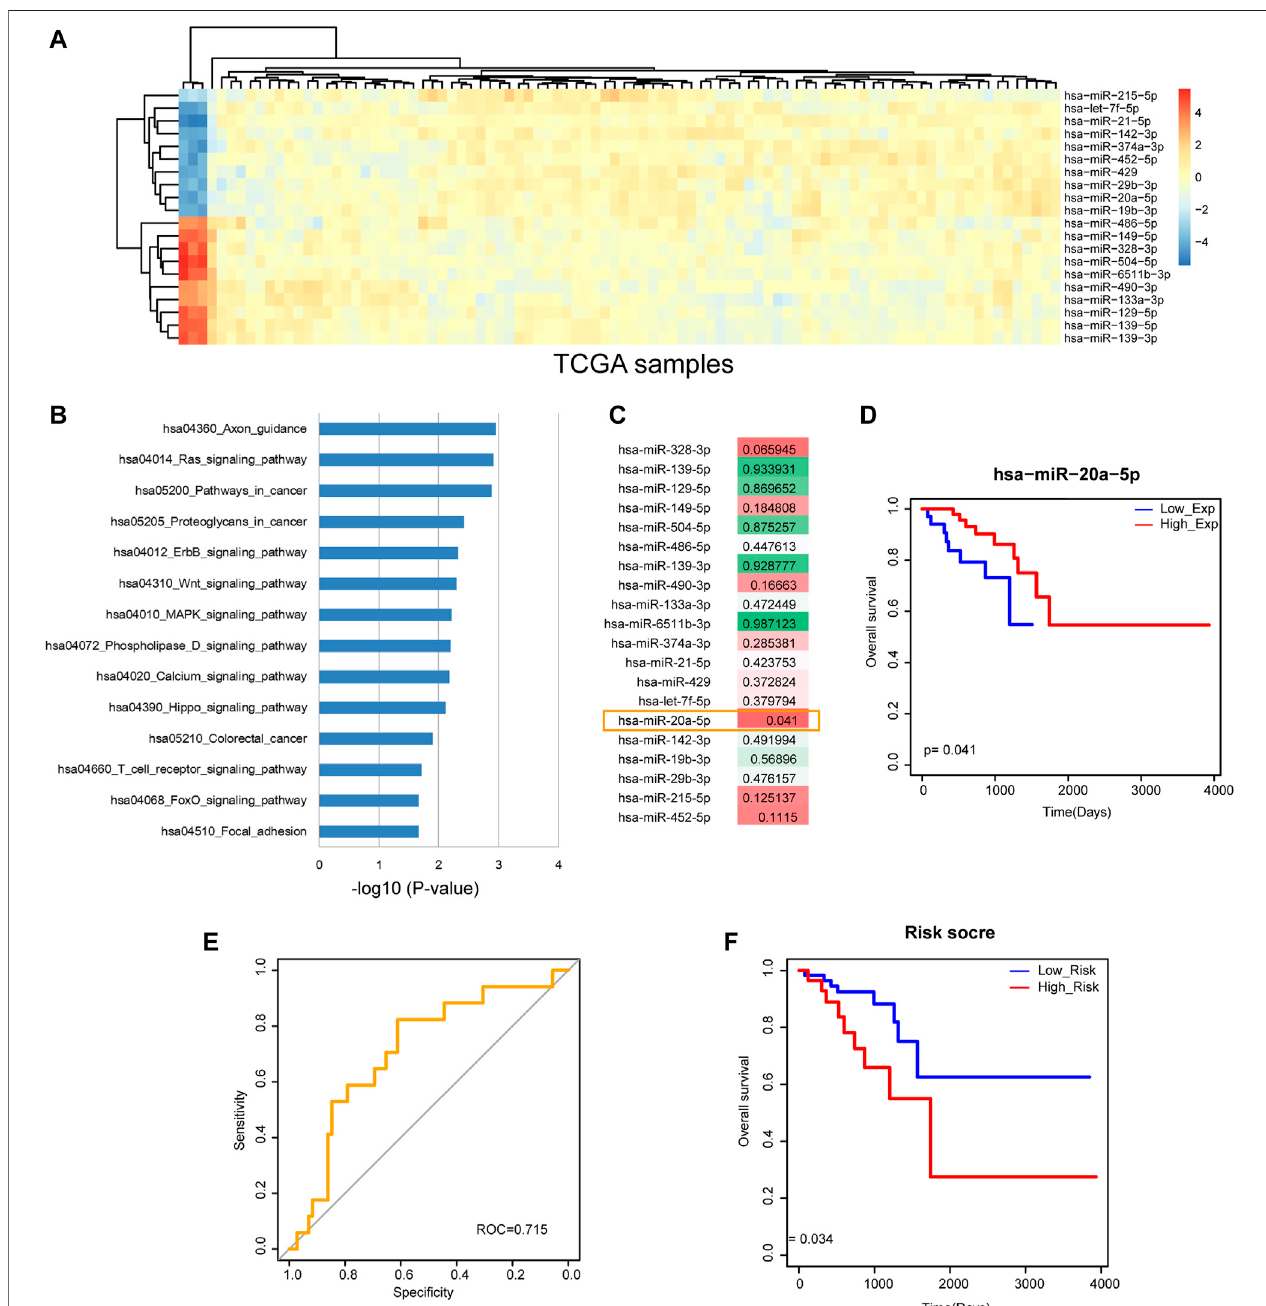
FIGURE1| Identi fi cationofthepotentialprognosisbiomarkerofrectalcancer. (A) Theheatmapofthemostupregulated10miRNAsandthemostdownregulated 10 miRNAs. (B) Pathway enrichment results of the 20 most DE miRNAs. (C) The log-rank p -values of the 20 most DE miRNAs. miR-20a-5p was statistically signi fi cant with p < 0.05. (D) AKaplan-Meiersurvivalcurveof miR-20a-5p ( p =0.041). (E) ROCcurveanalysisresultofthe20mostDEmiRNAs. (F) AKaplan-Meiersurvivalcurveof the 20 most DE miRNAs ( p = 0.034).